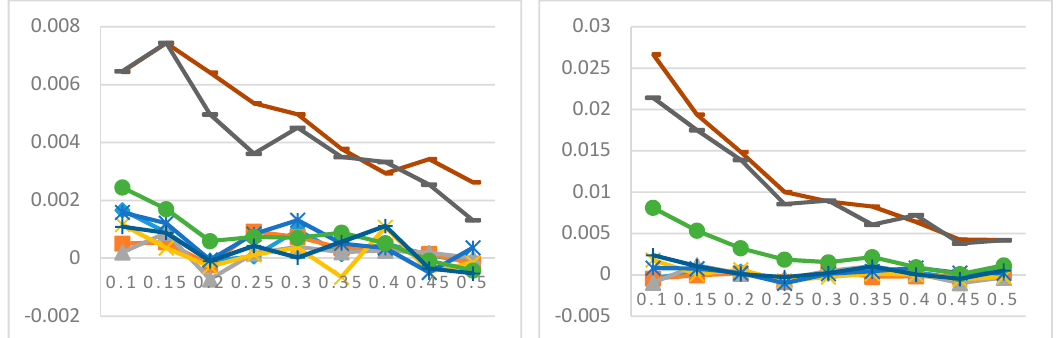
Figure 3. In the single-point contact SIR model, the relative proportion index of node group influence Δ varies with the infection rate β . From left to right corresponds to taking 1%, 3% and 5% of the number of nodes in the dataset as the number of nodes in the key node group respectively.